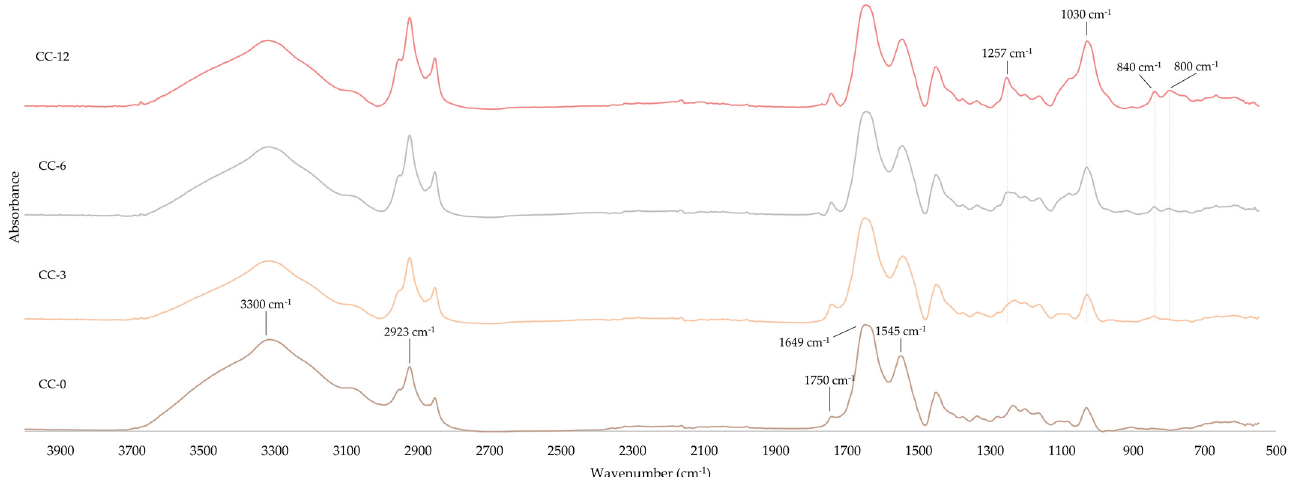
Figure 2. FTIR spectra of the untreated leather sample and leather samples coated with plasma- polymerised HMDSO.